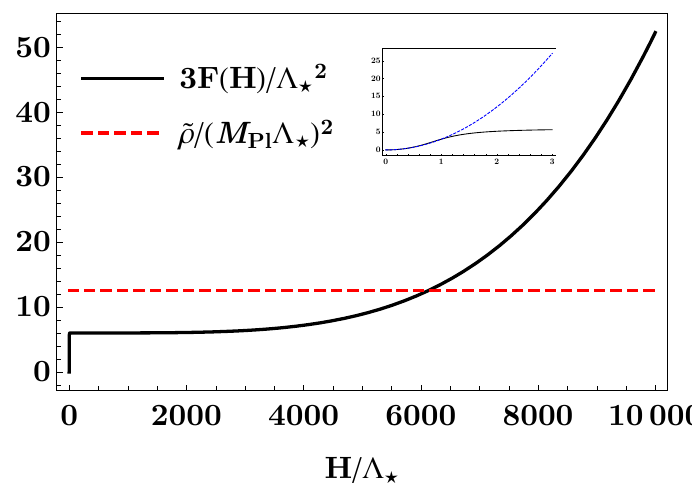
Figure 1 . Initial set up in the power law model with parameters Λ inf = 6000 Λ ? , m = 500 Λ ? and an initial value ˜ φ = 0 . 01 M Pl . Inset: Zooming in showing that F ( H ) approaches the GR value — blue dashed line — , H 2 , as H → 0